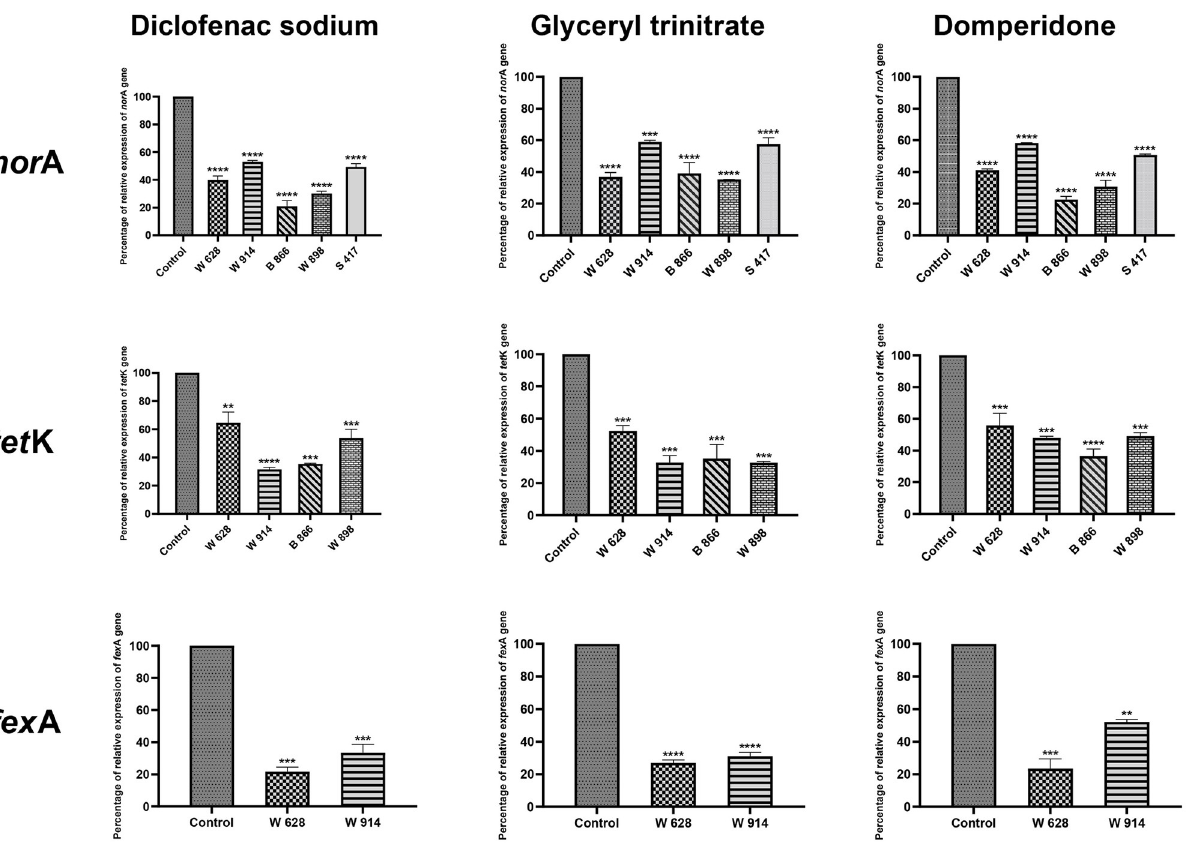
Fig 6. Down-regulation of nor A, tet K and fex A genes of S . aureus by diclofenac sodium, glyceryl trinitrate and domperidone which all produced significant reduction in the expression levels of these genes. The data shown represent the means ± standard errors. One Way ANOVA test followed by Dunnett’s Multiple Comparison test was used for the statistical